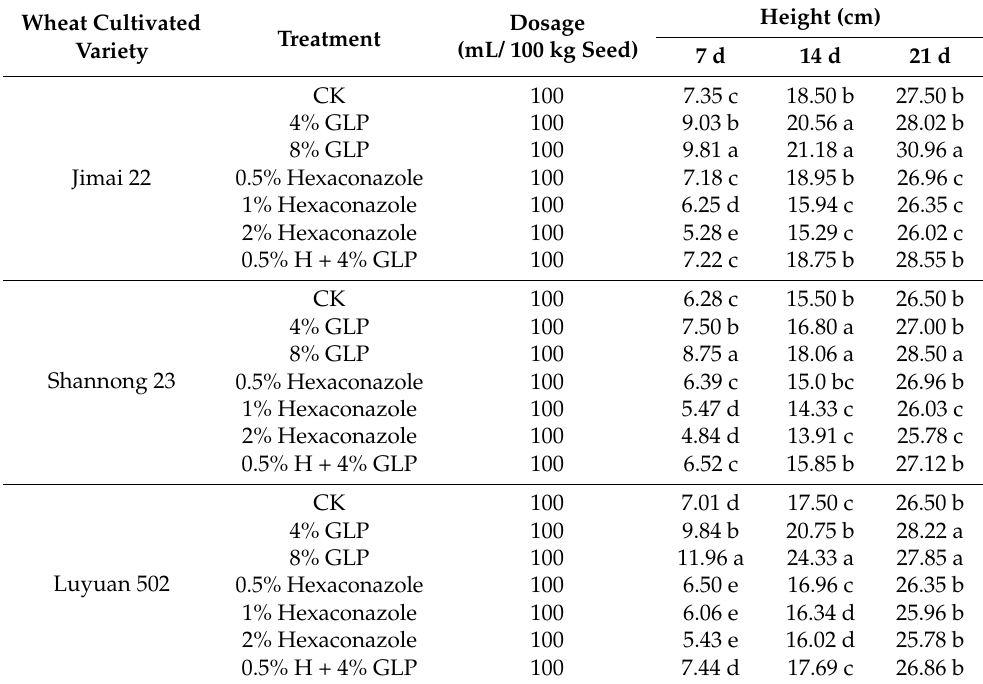
Table 7. Effects of seed dressing on the growth of wheat seedlings.